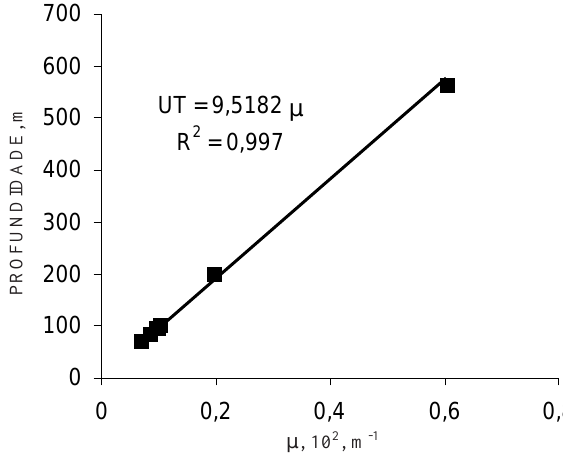
Figura 1. Relação entre coeficiente de atenuação linear (µ) e unidades tomográficas (UT), na calibração do tomógrafo computadorizado através da utilização dos meios conhecidos e